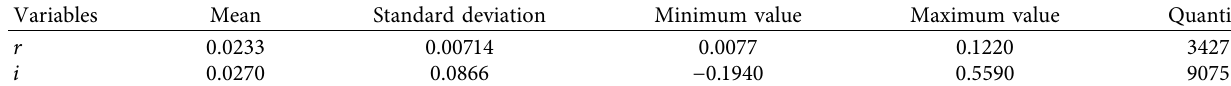
Table 1: Descriptive statistics of interest rates and inflation rates.